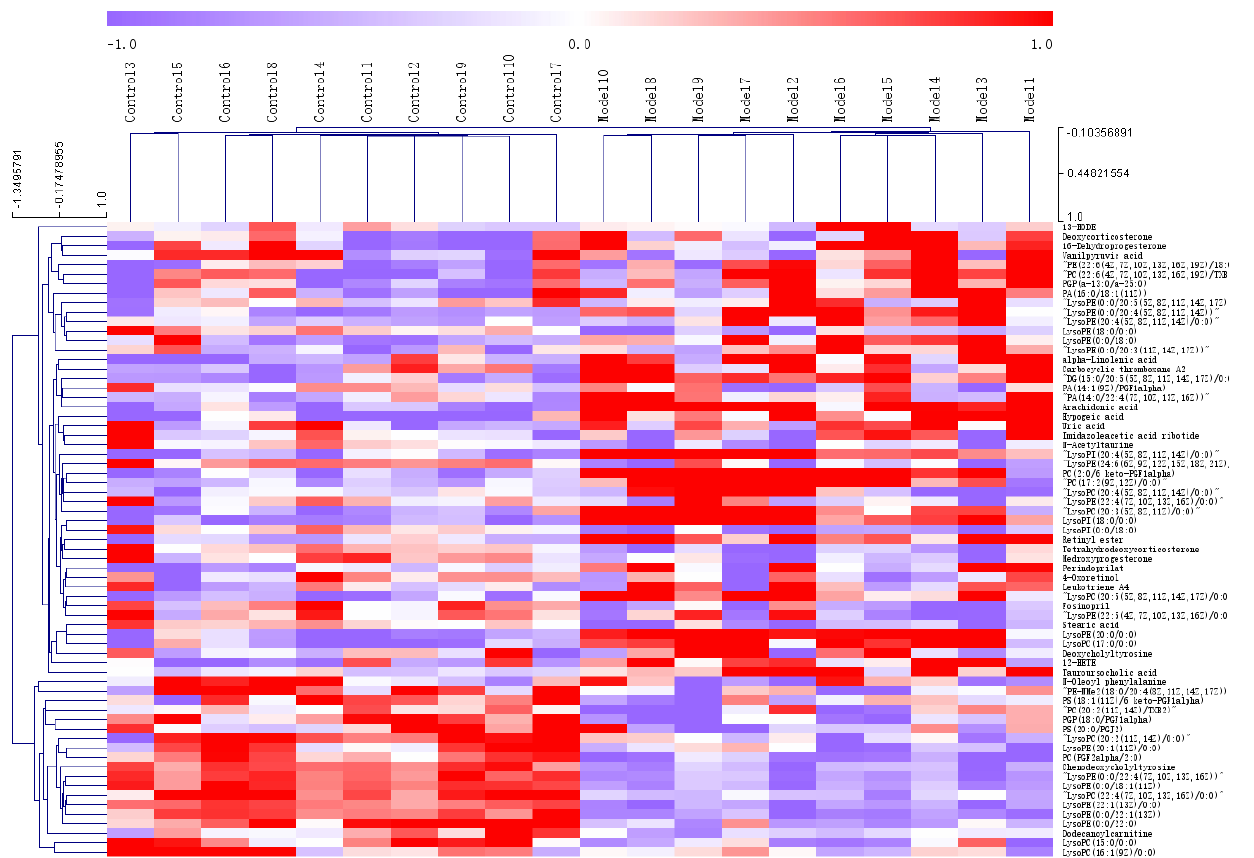
Figure 7. Heat map analysis of differential metabolites in T2D db/db mice. (Control 1 – 10 represents Table 1. Model represents the model group).